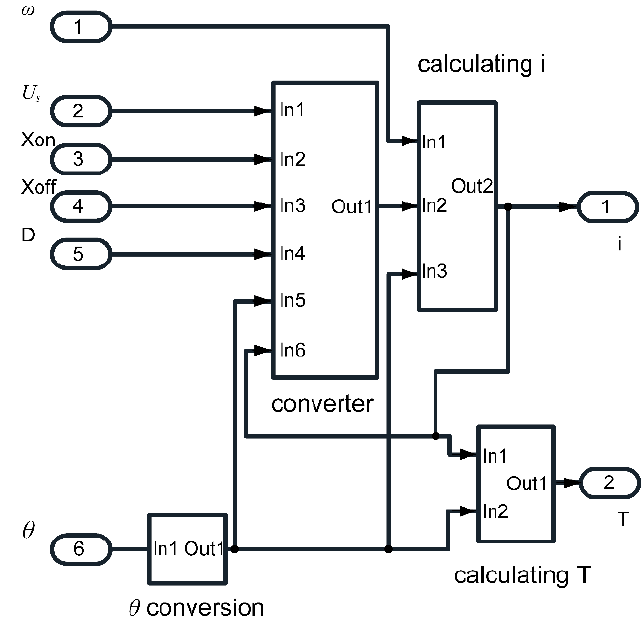
Figure 6. One phase simulation module.